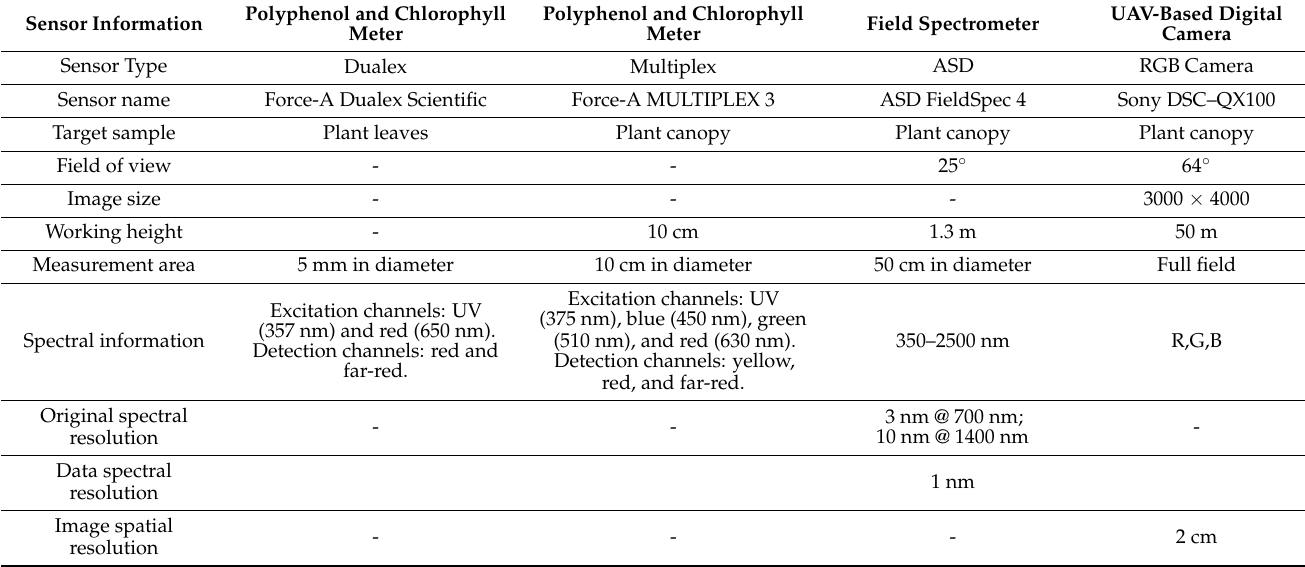
Table 2 lists the detailed information on the sensors used in this study. Table 2. Parameters on sensors used in this